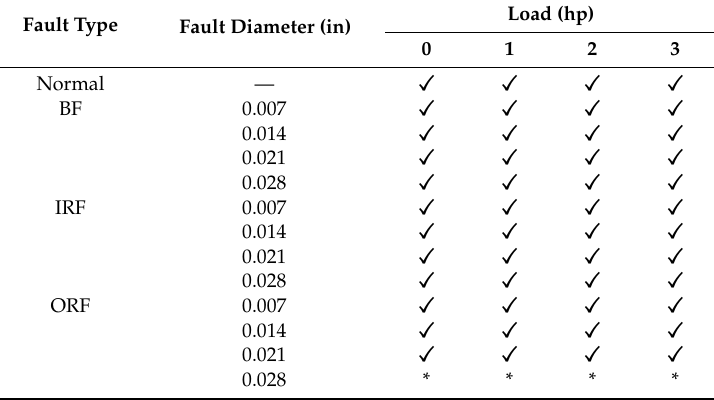
Table 3. Working conditions of the collected rolling bearing